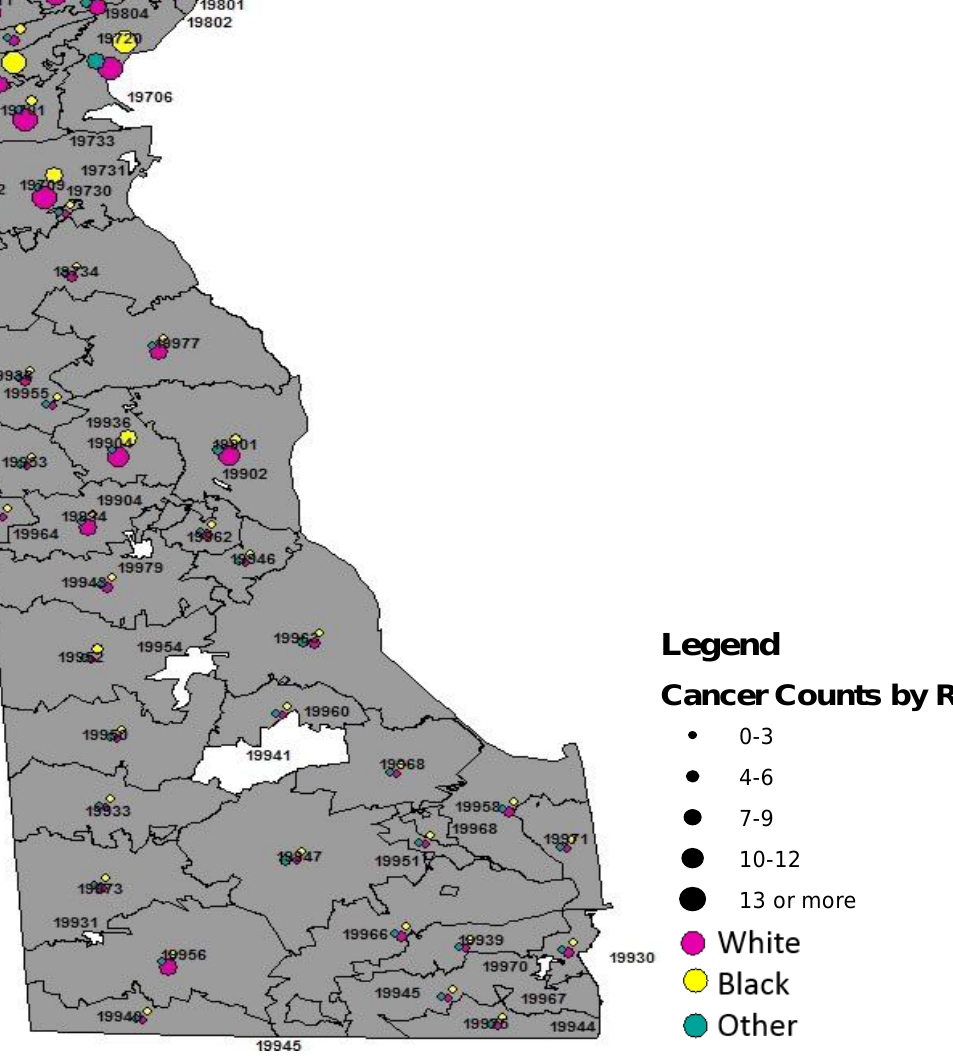
Figure 4. Racial Mapping of Childhood Cancer in Delaware State, 2004–2014.